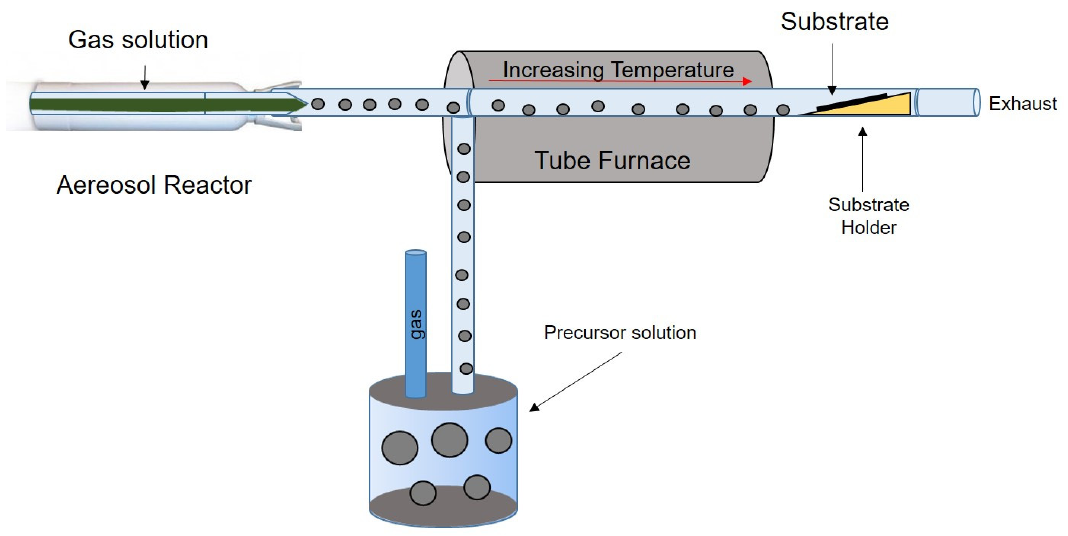
Figure 4. Schematic representation of a typical spray pyrolysis process.